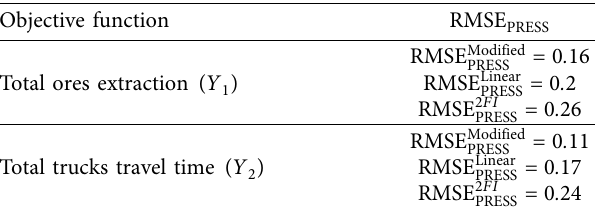
Table 8: Validation of the meta